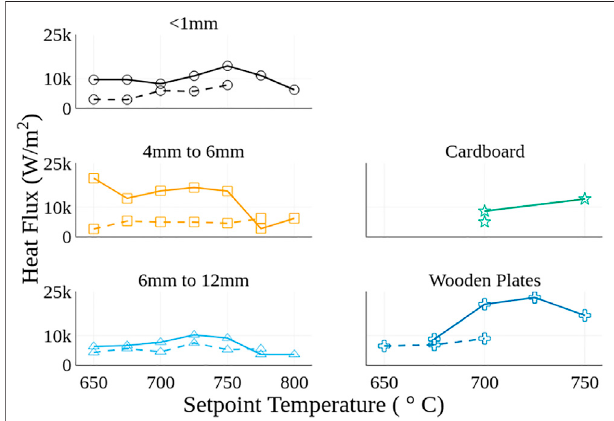
FIGURE 7 | Comparison of estimated heat fl ux to the fuel bed for each material:dashedlinesrepresentsthemeanofnon-ignitiontestsandsolidlines represent the mean of ignition tests for each heater